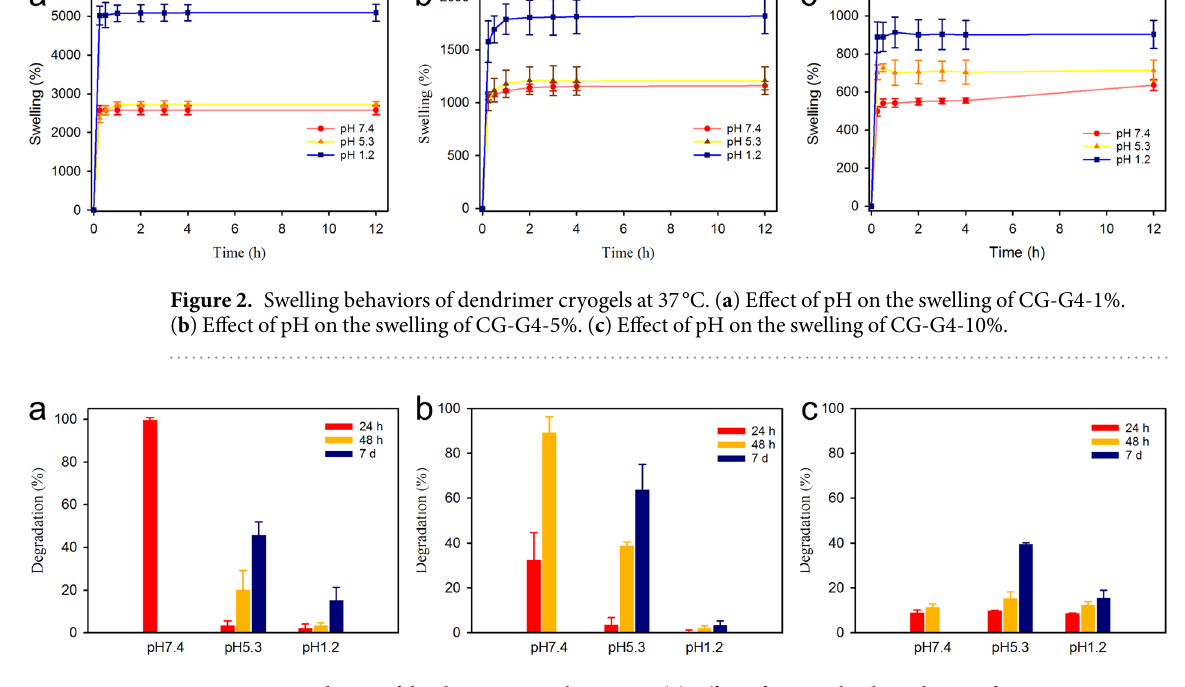
Figure 3. Degradation of dendrimer cryogels at 37 °C. ( a ) Effect of pH on the degradation of CG-G4-1%. ( b ) Effect of pH on the degradation of CG-G4-5%. ( c ) Effect of pH on the degradation of